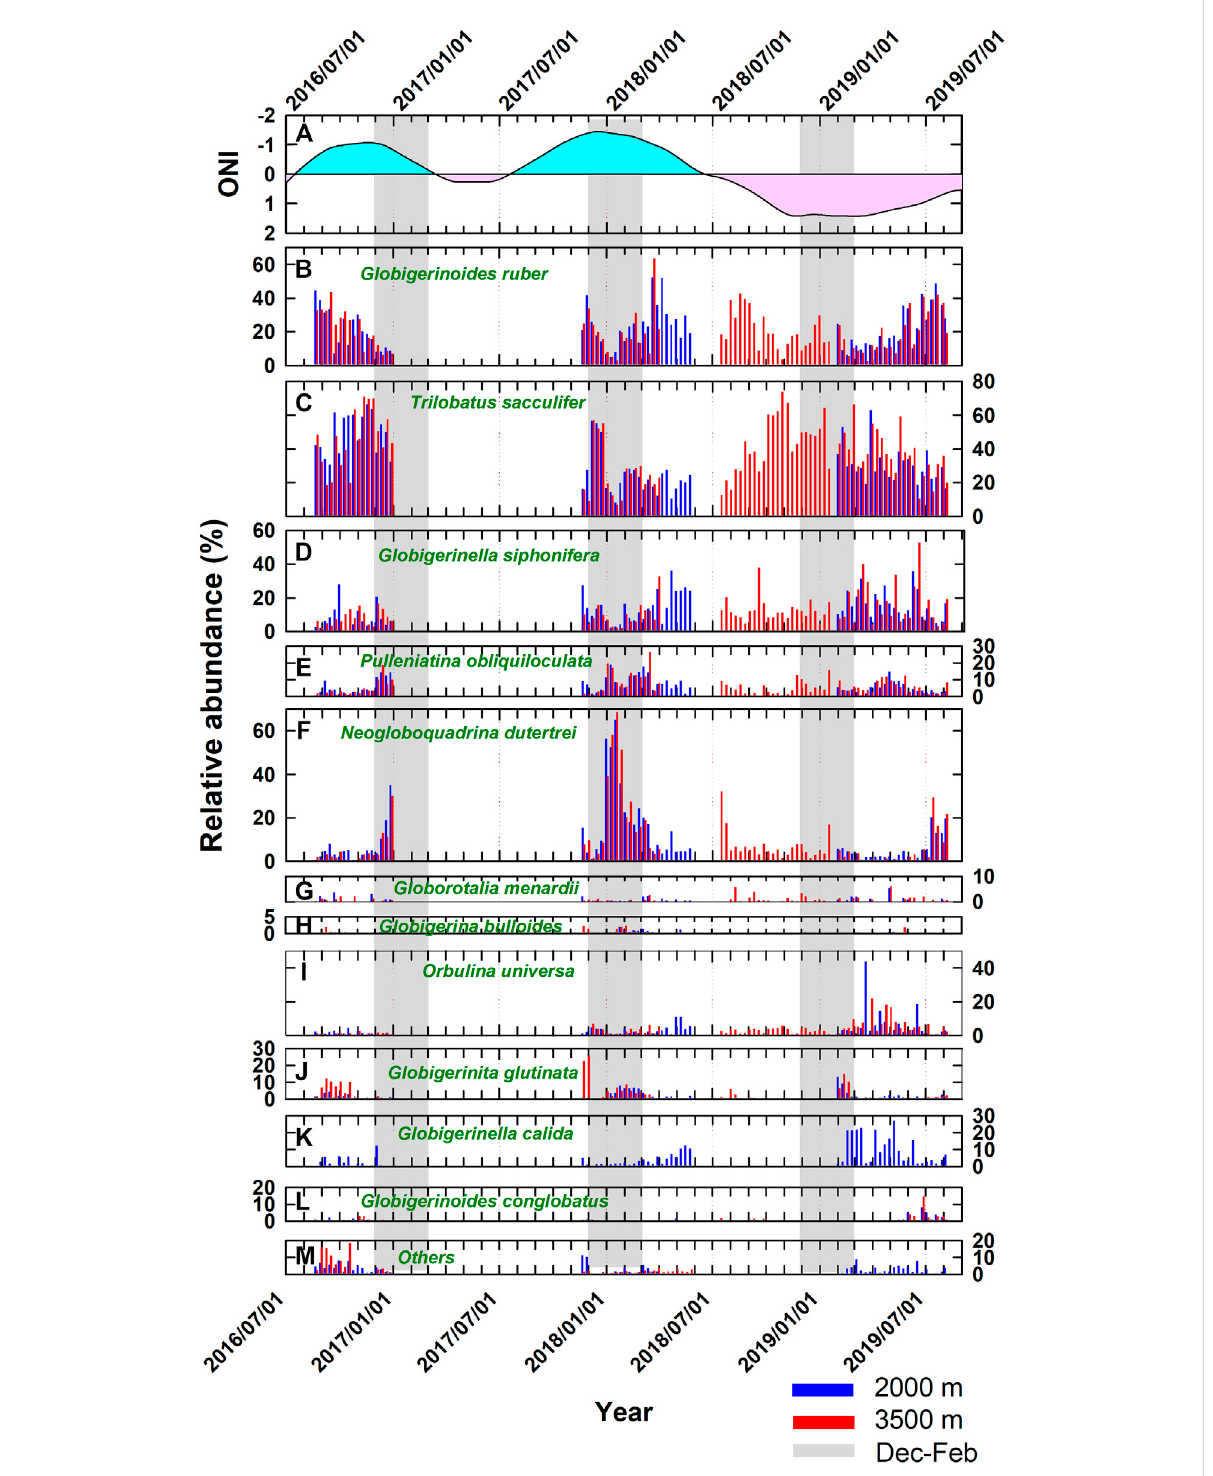
FIGURE 5 Time series of (A) ONI (pink and light blue areas refer to positive and negative values, respectively) and relative abundance of (B – L) 11 species and (M) others for the four collection intervals in a consecutive sequence. Gray bars indicate the periods of December to